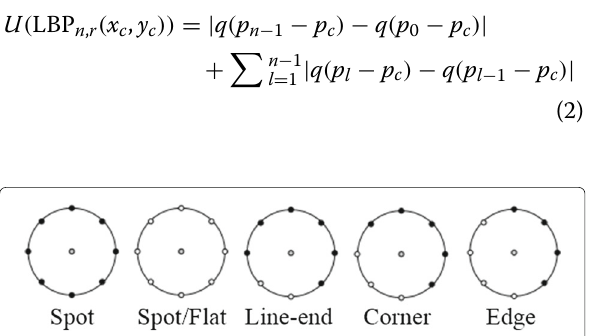
Fig. 3 Example of micro-structures encoded by LBP-based